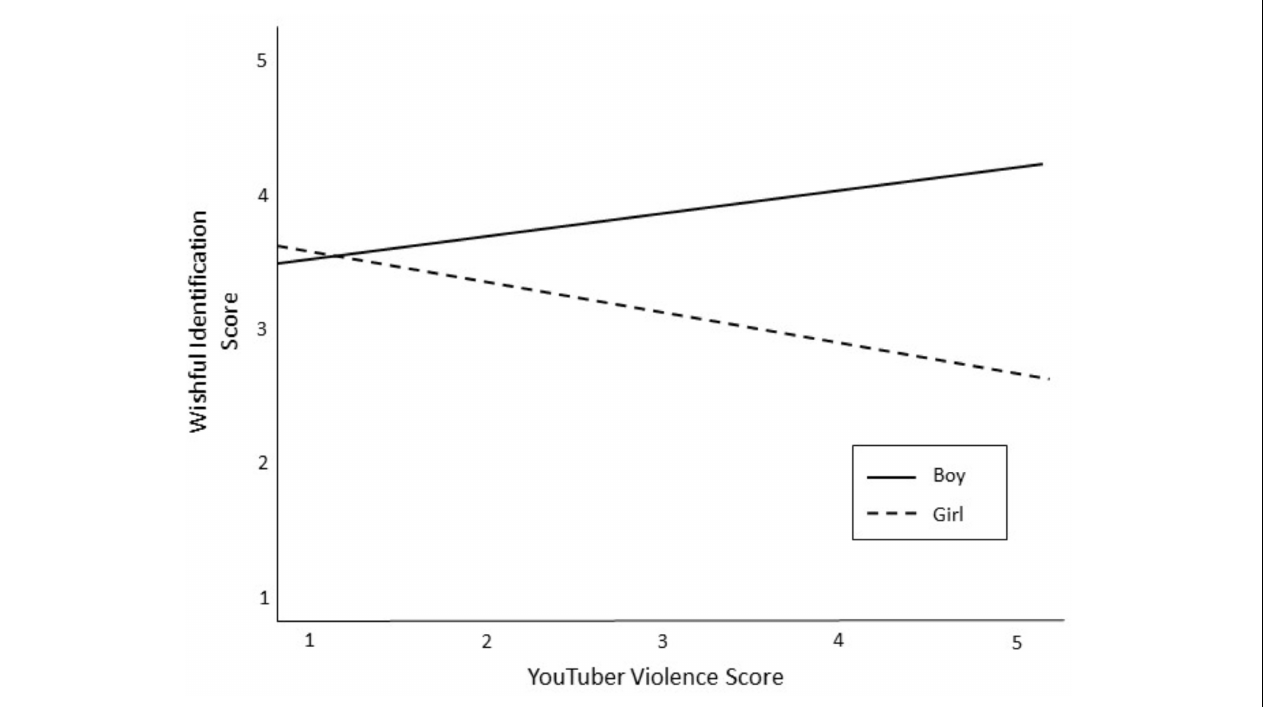
FIGURE 1 | The relationship between YouTuber violence and WI as moderated by gender of child.